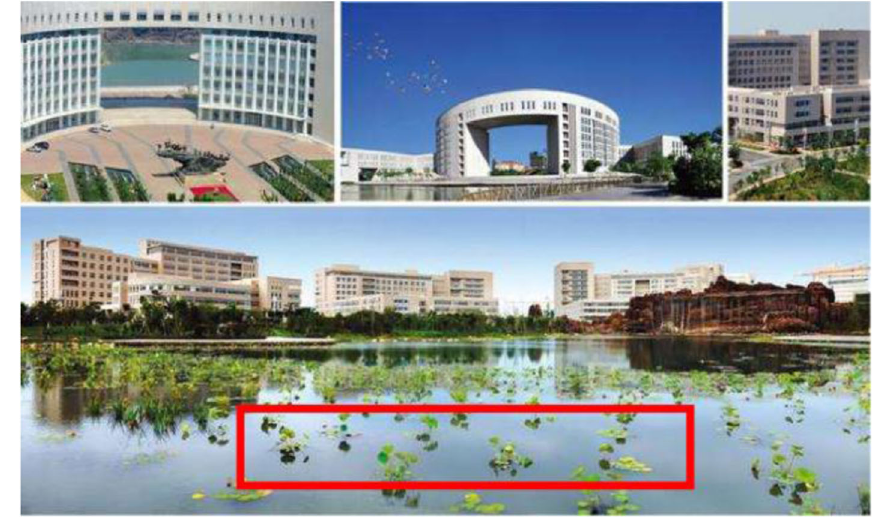
Fig. 26 Landscape Lake and green belts in eco-city